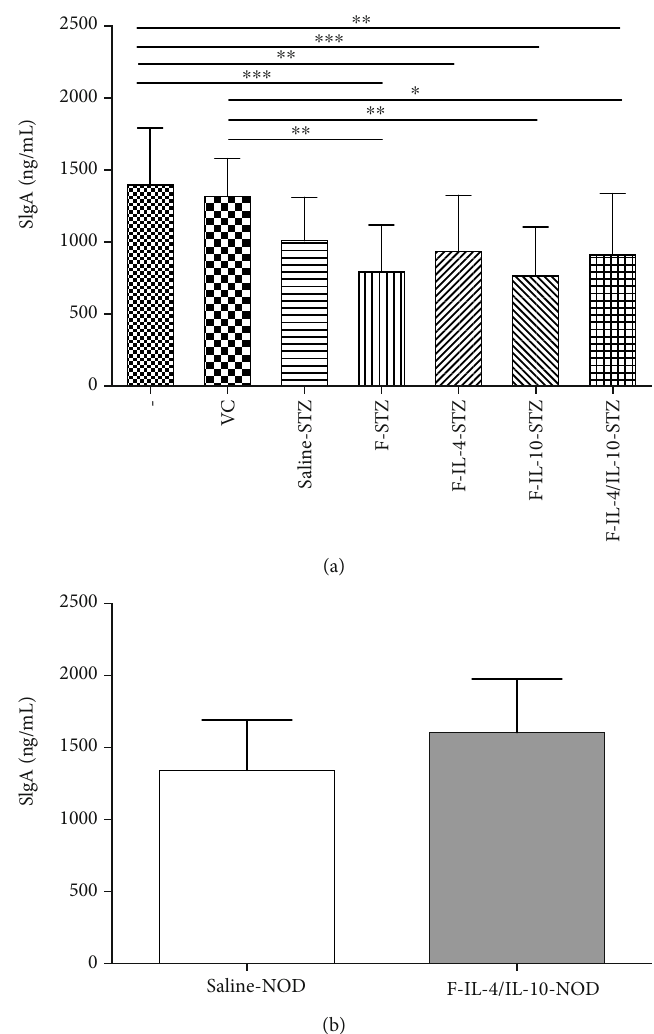
Figure 6: sIgA levels in intestinal lavage fl uid from STZ-induced C57BL/6 mice and NOD mice, which were both treated with oral bacterial administration. Secretory IgA levels from (a) STZ-induced C57BL/6 mice ( n = 18 ) and (b) NOD mice ( n = 12 ). – : negative control; VC: